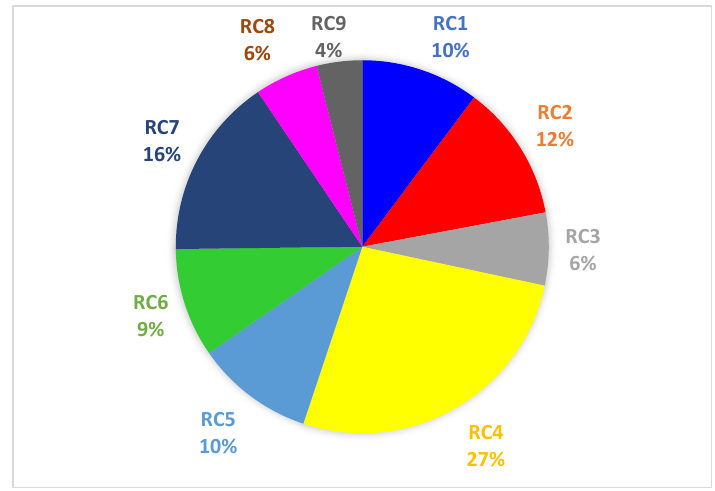
Figure 2. Categorization of reviewed papers.